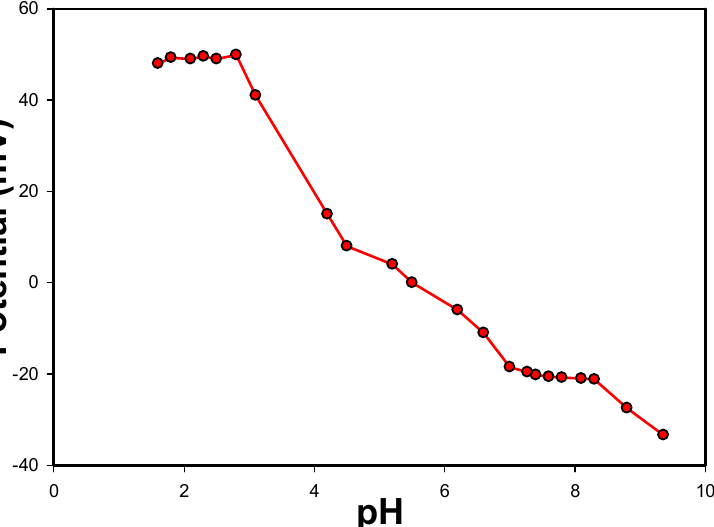
Figure 6. pH effect on the measured potential response (potential, mV) of sensor 4 at 25 °C for 10 − 3 M